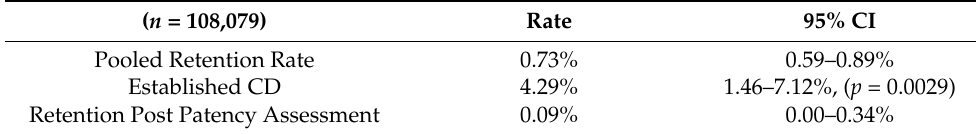
Table 2. Rates of capsule retention and trend over time (data from Wang et al.